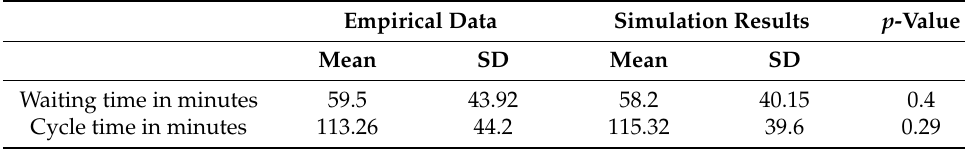
Table 1. Simulation model validation in terms of waiting time and cycle time.